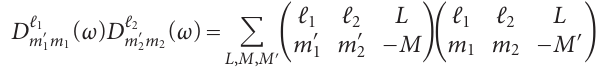
Figure 2: Diagrammatic representation of the 2, 3, 4, and 5-point correlation functions in harmonic space. Here pair ( (cid:5) , m